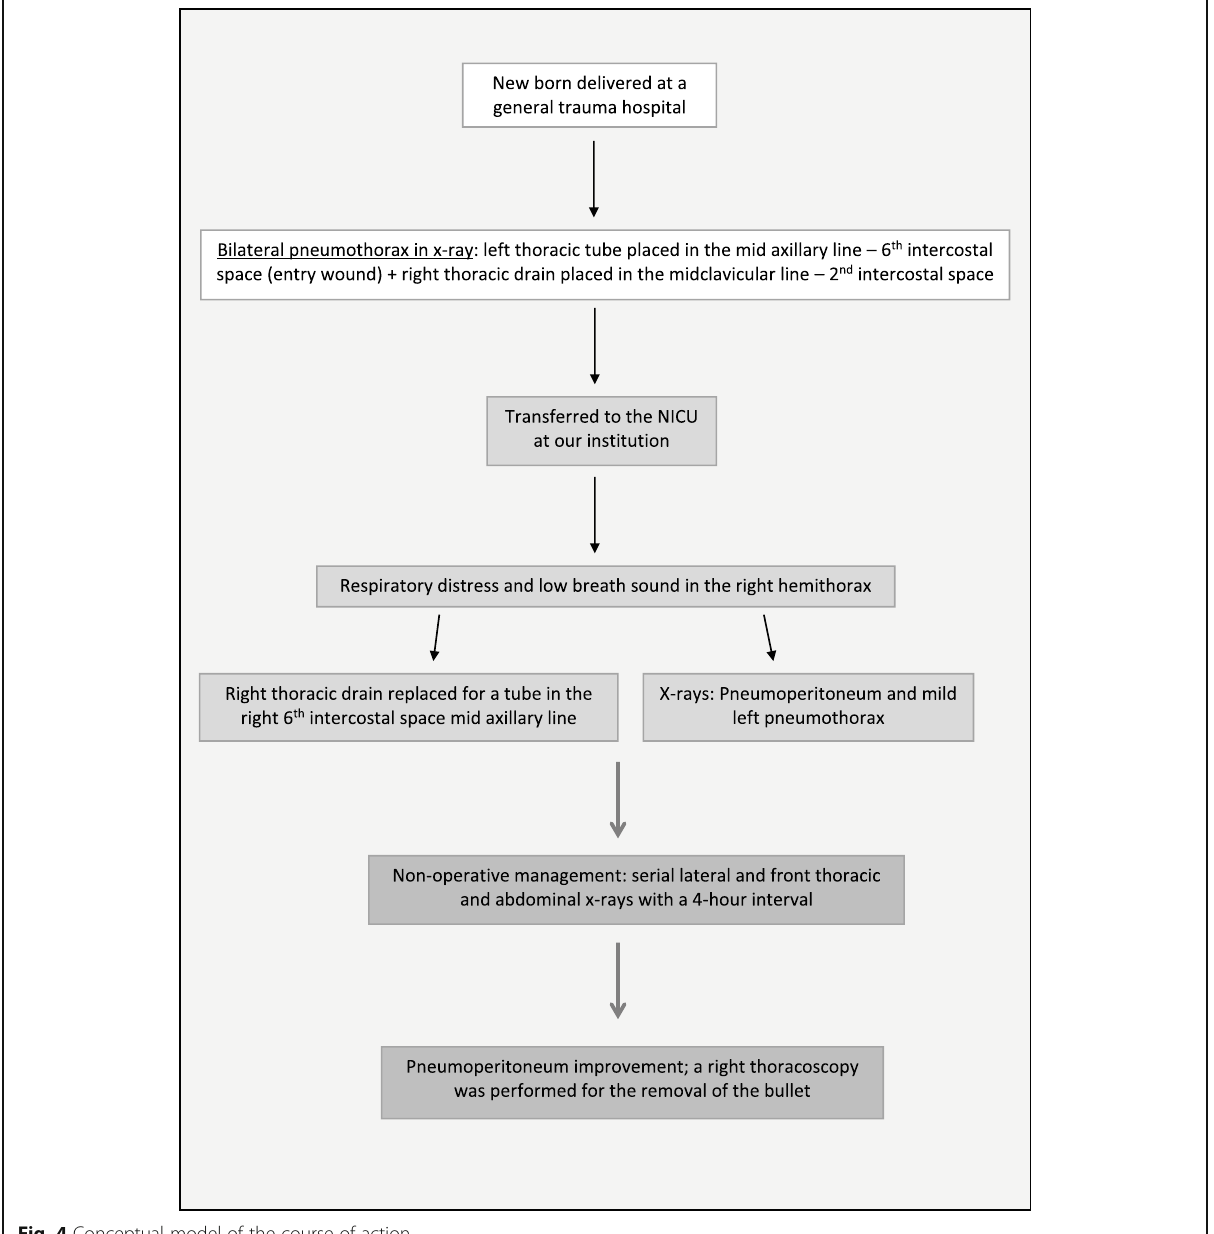
Fig. 4 Conceptual model of the course of